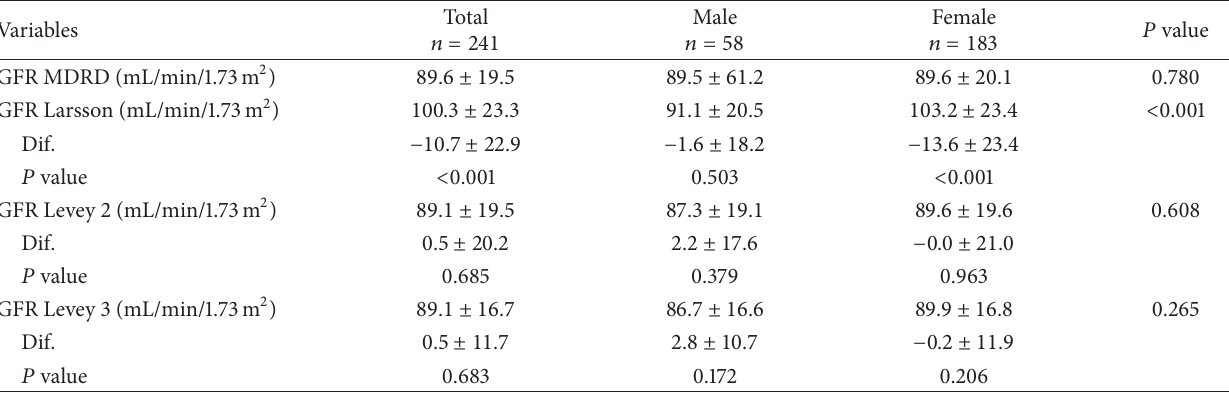
Table 2: Differences between the glomerular filtration rate estimated by the modification of diet in renal disease and glomerular filtration rate estimated by Larsson, Levey 2, and Levey 3 equations by